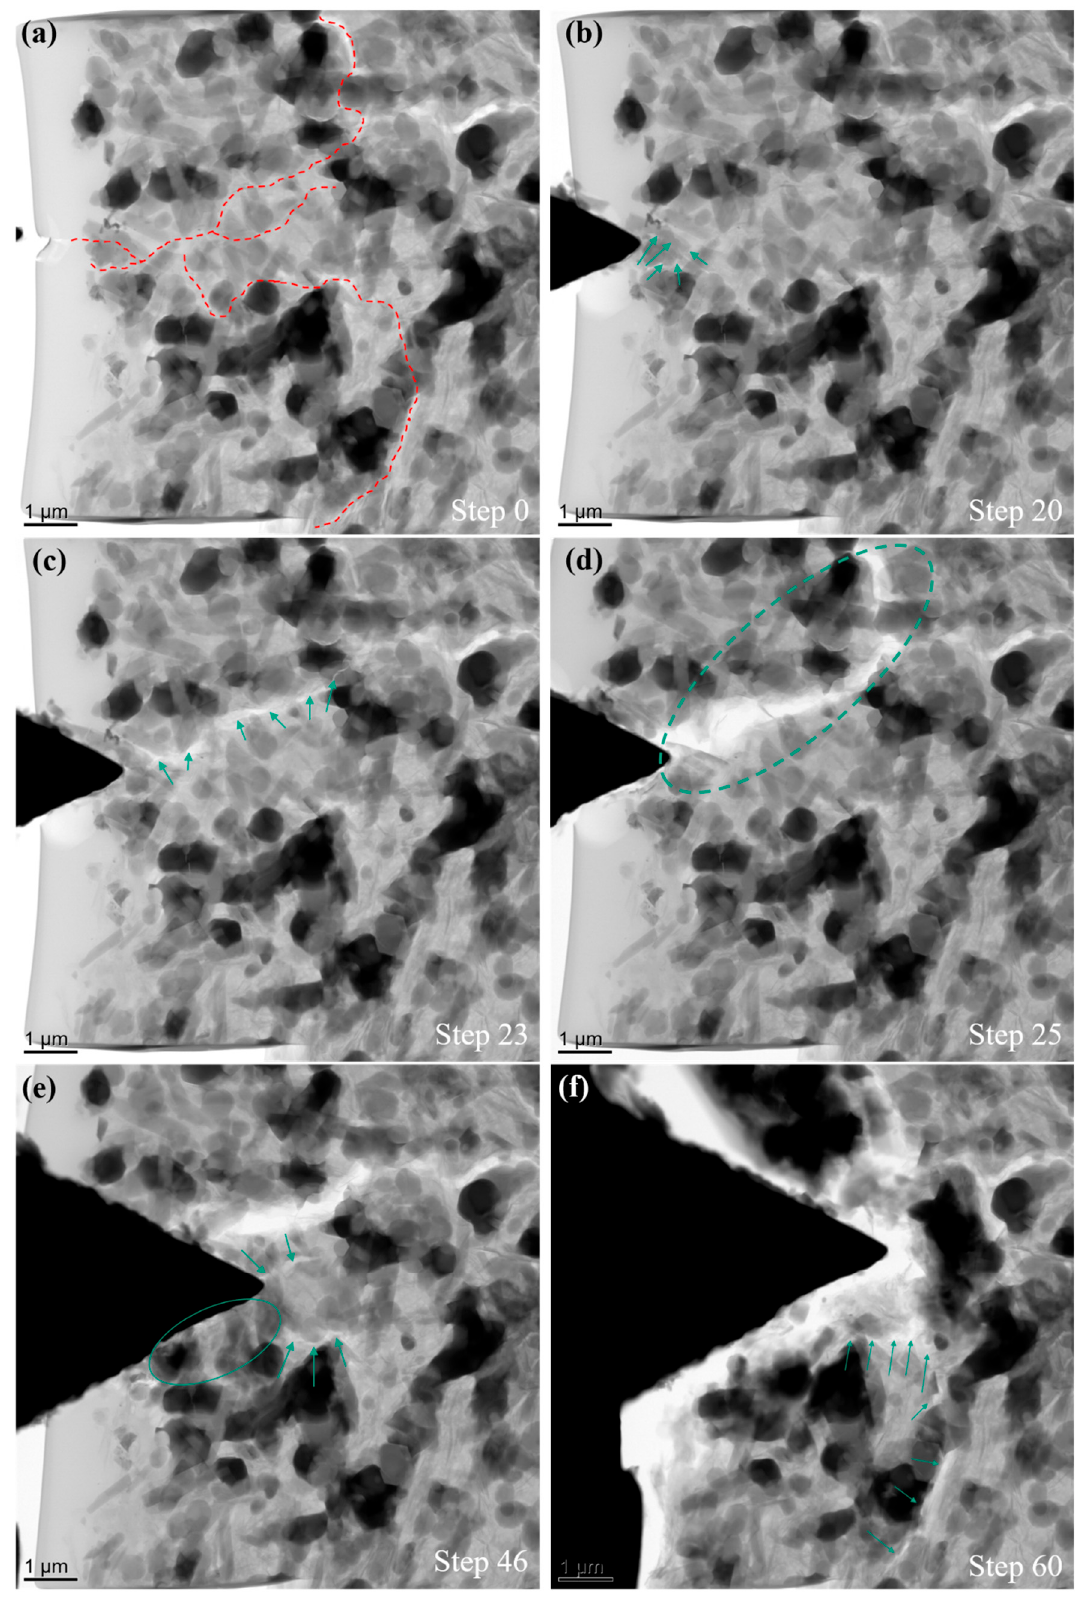
Figure 7. Representative TEM images selected from an in-situ experiment for a composite with 30 wt.% MLG. ( a ) Before the in-situ experiment, major cracks observed in the following experiment are highlighted by dashed lines; ( b , c ) the initiation and propagation of first crack, highlighted by green arrows; ( d ) delamination caused by the first long crack; ( e , f ) development of further cracks before retracting the indenter.